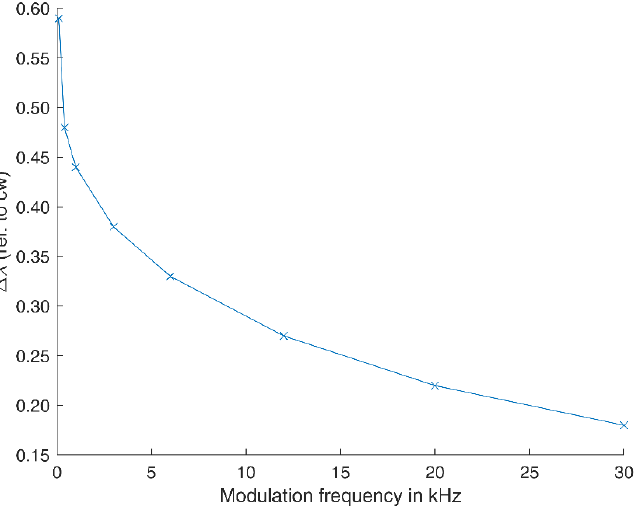
Figure 3. Spectral dynamic range Δ λ (relative to cw) as function of modulation